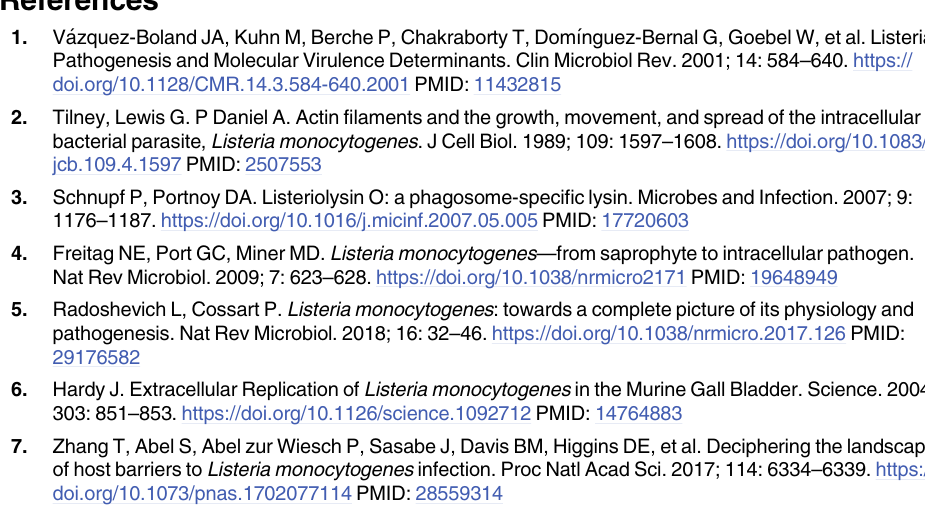
S1 Text. Table A in S1 Text. All Rex repressed genes during stationary phase . Table B in S1 Text All Rex repressed genes during mid-log phase. Table C in S1 Text All transcripts less abundant in Δ rex during stationary phase. Table D in S1 Text All transcripts less abundant in Δ rex during mid-log phase. Table E in S1 Text Predicted Rex binding sites in the 10403S genome. Table F in S1 Text L . monocytogenes strains used in this study. Table G in S1 Text E . coli strains used in this